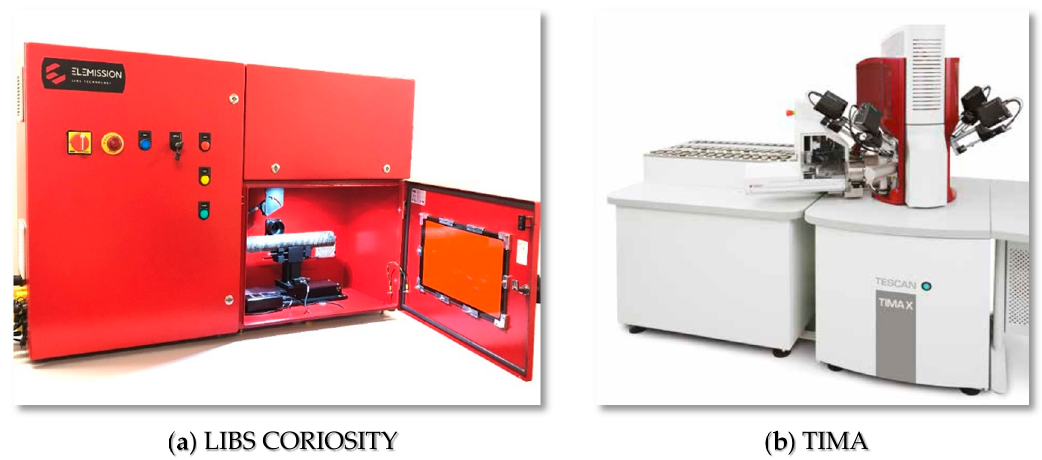
Figure 1. ( a ) LIBS CORIOSITY mineral analyzer and ( b ) TIMA-X with a 100-sample autoloader.